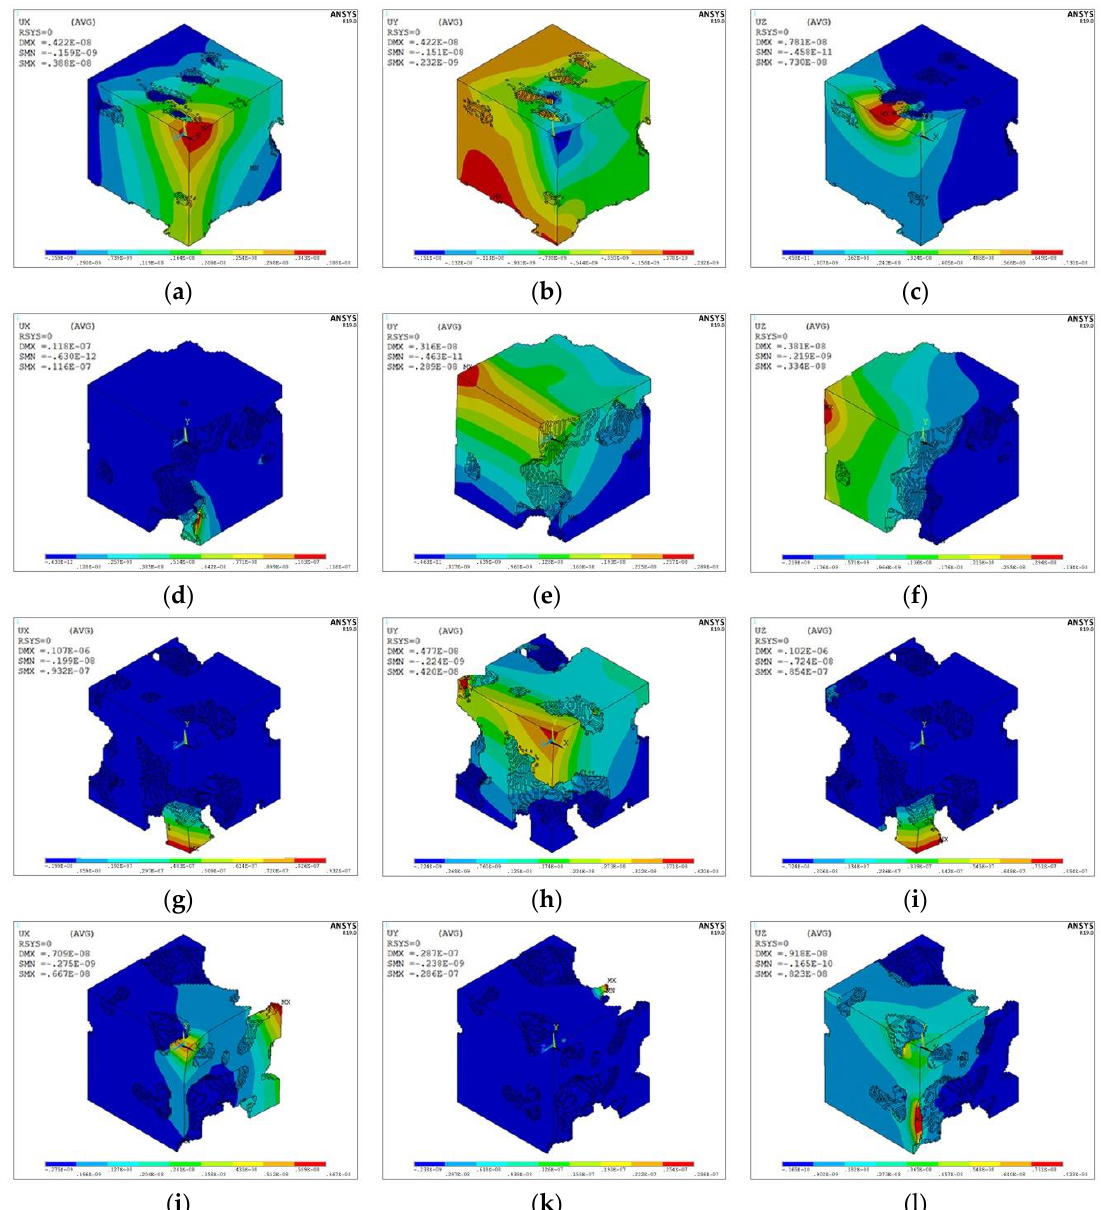
Figure 11. Displacement analysis results of micron silver sintered joints under different thermal shocks by fixing X, Y and Z planes, respectively: ( a – c ) 50; ( d – f ) 100; ( g – i ) 150; ( j – l ) 250 cycles.